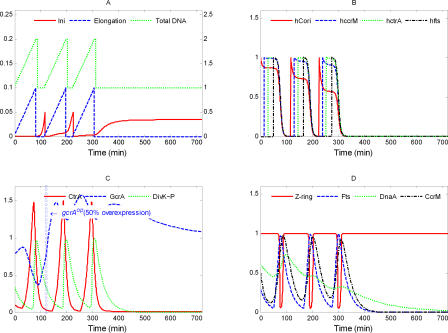
Simulation of gcrAop: k′ = 0.0225 (50% of WT)